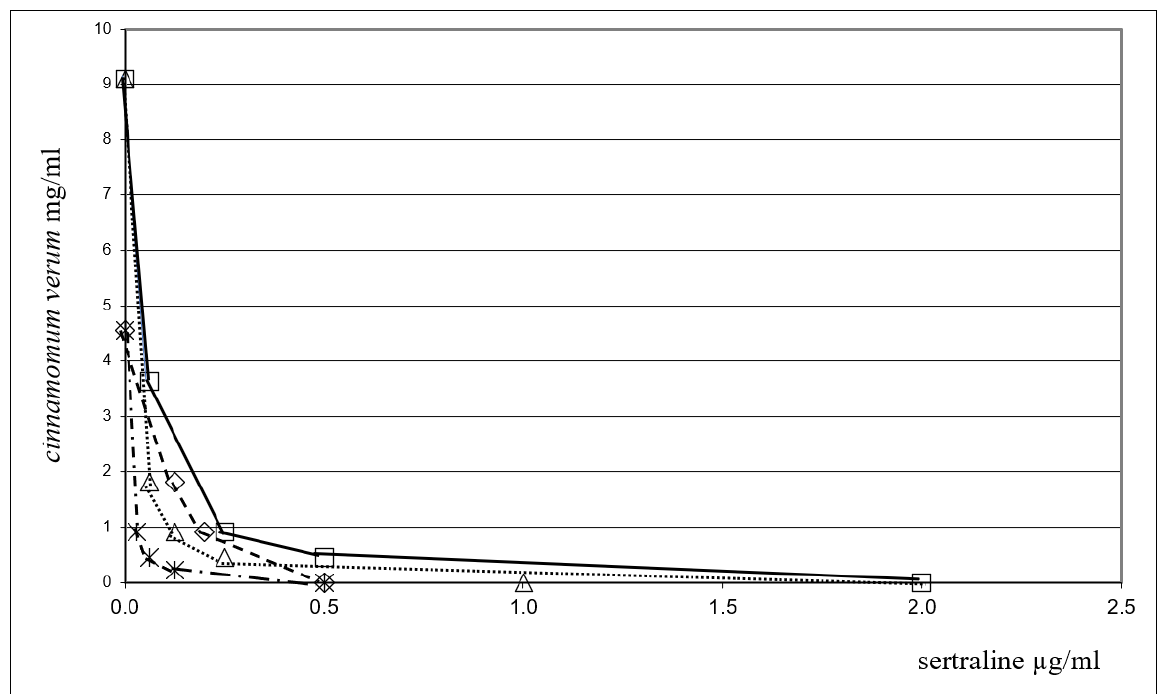
Figure 1. Isobole curves revealing the synergistic effect of sertraline with CEO in inhibiting four bacterial strains. P. aeruginosa ATCC 27853, E. faecalis ATCC 29212, K.pneuomoniae ATCC 13883, B.subtilis ATCC 6633.